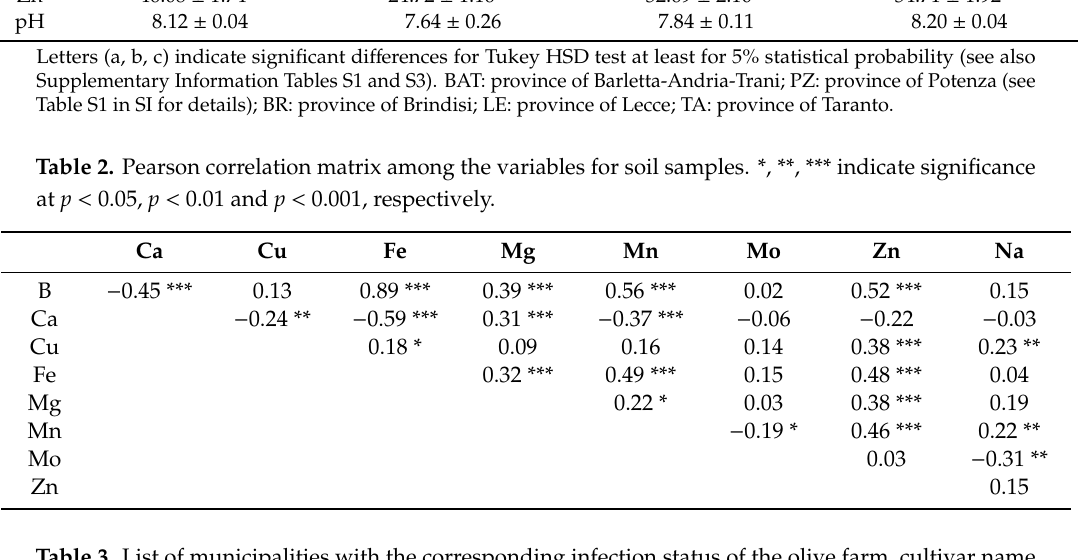
Table 3. List of municipalities with the corresponding infection status of the olive farm, cultivar name and number of soil and leaf samples taken for the study. BAT: province of Barletta-Andria-Trani; PZ: province of Potenza; BR: province of Brindisi; LE: province of Lecce; TA: province of Taranto. TR (farm treated with zinc–copper–citric acid), NTR (farm not treated and infected by Xylella fastidiosa subsp. pauca ) or NI (farm not infected by Xylella fastidiosa subsp. pauca ). Ogliarola: Ogliarola salentina; Cellina: Cellina di Nard ò . The olive groves of BAT and PZ provinces are located in the “free” area, whereas all the other are located in the “infected”